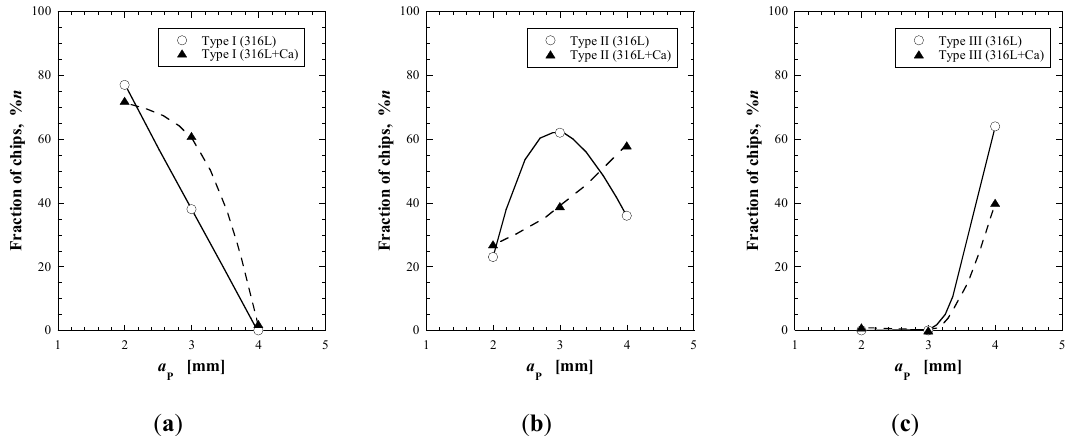
Figure 7. Chip weight distributions for Type I ( a ), Type II ( b ), and Type III ( c ) chips obtained at an f n value of 0.5 mm/rev and a cutting speed of 180 m/min.